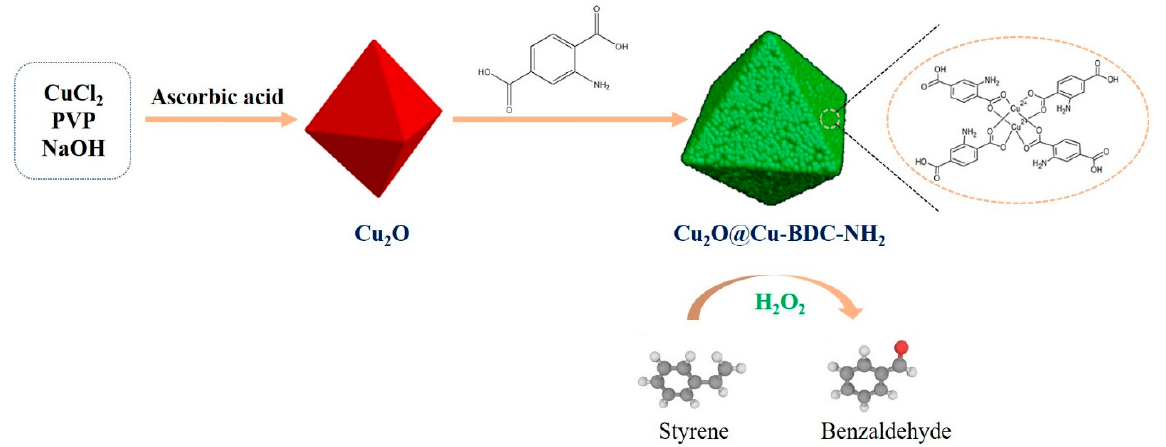
Scheme 1. The illustration of the synthetic process from Cu 2 O toward Cu 2 O@Cu-BDC-NH 2 for the selective oxidation of styrene with H 2 O 2 as green